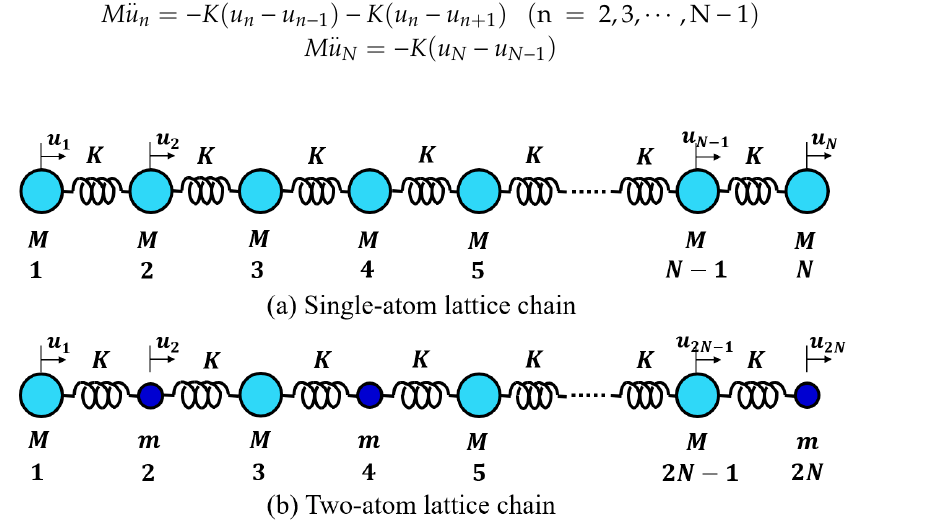
Figure 10. 1D thermal conduction model of a ferroelectric under open-circuit condition.